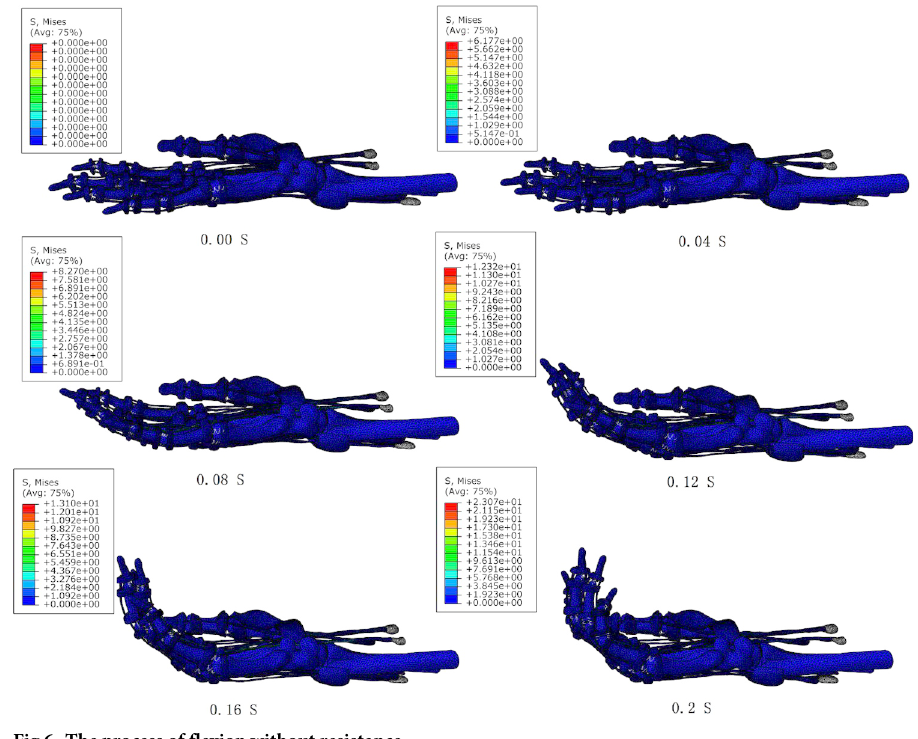
Fig 6. The process of flexion without